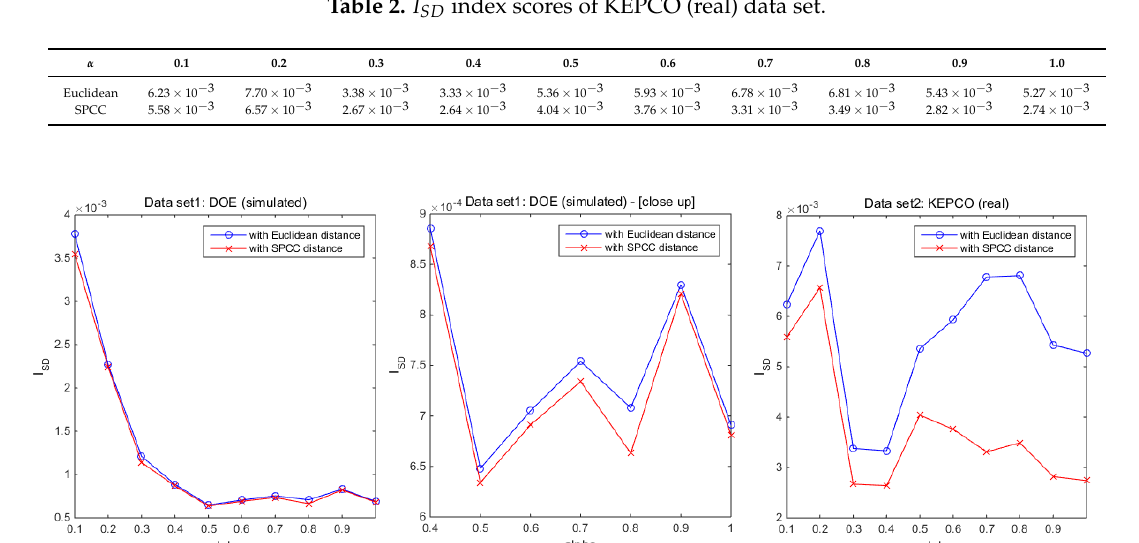
Table 2. I SD index scores of KEPCO (real) data set.